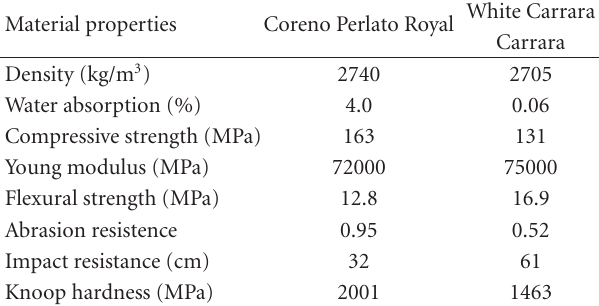
Table 2: Mechanical properties of Coreno Perlato Royal and White Carrara marbles.